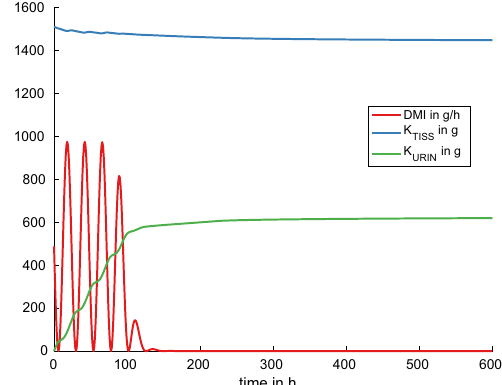
(a) The model components K ECF , K ICF , and Gluc B : hypokalemia with K ECF falling below 3.9 mmol/L occurs at time t = 155h, and hypo- glycemia with Gluc B below 0.4 g/L occurs at time t = 523h.